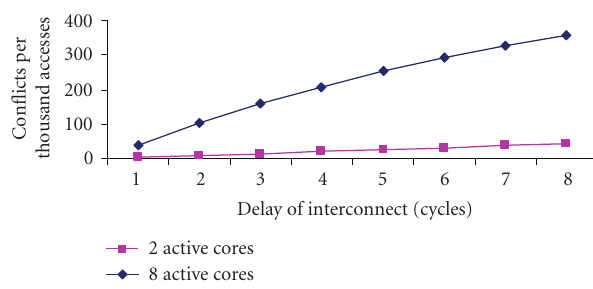
Figure 1: Conflicts per thousand accesses for a shared-bus inter- connect as more cores are made active and the delay of interconnect increases for a workload consisting of random SPEC